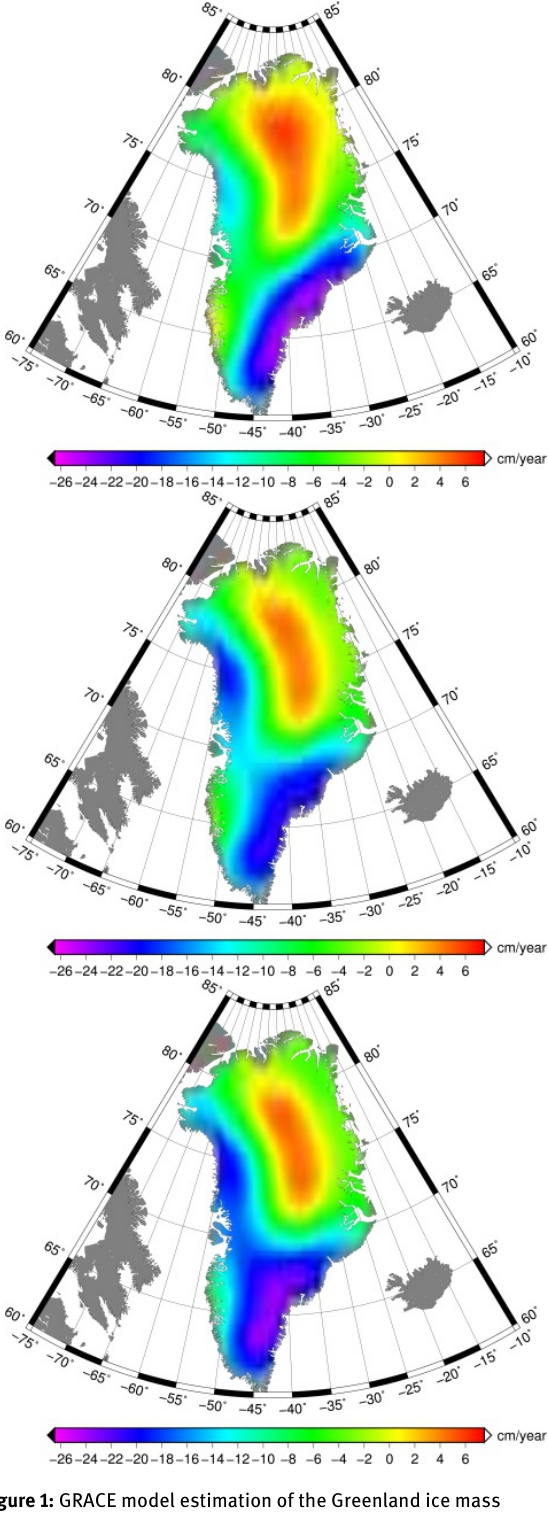
Figure 1: GRACE model estimation of the Greenland ice mass loss rate in units of equivalent water thickness change per year, cm/year. The figures are (top) the averaged rate from January 2003 to December 2007, (middle) from January 2003 to December 2010, and (bottom) January 2003 to December